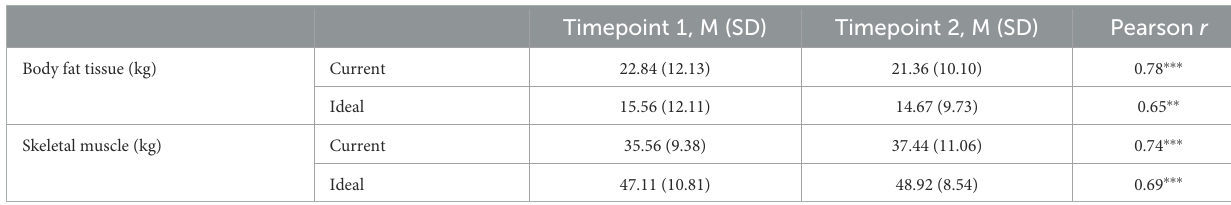
TABLE 5 Mean (SD) scores and Pearson correlation coefficients for “current,” “ideal” body composition judgements at each